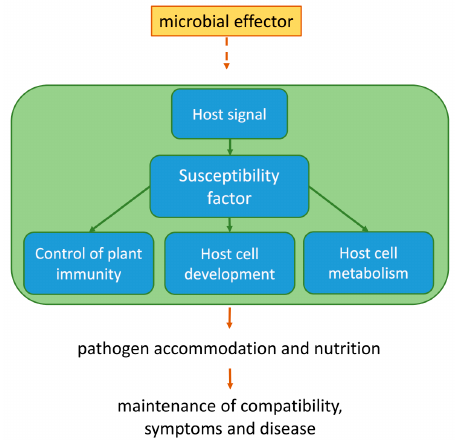
Figure 1. Plant physiological functions and microbial utilization of host susceptibility factors (S). Host S factors can have diverse physiological functions (highlighted by the green background box), which would also operate in pathogen-free plants. This can include control of immune responses or normal host cell development and metabolism. In healthy plants, S factors are regulated by host endogenous signals (e.g., hormones, peptides, second messengers, protein-protein interaction, and protein modification). Microbial pathogens can simply profit from S factor functions or they actively take advantage of S factors via virulence effectors. Effectors might directly act on S factors or on their physiological